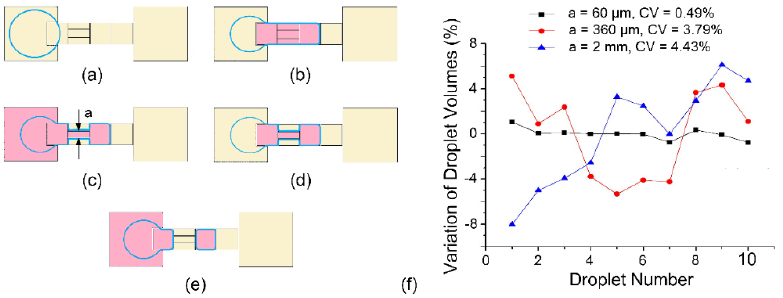
Figure 3. Droplet dispensing process with a new electrode design. ( a – e ) Schematic of the dispensing process. ( f ) Volume variation of droplets dispensed consecutively with the sub-electrodes of different widths. Each dot is averaged over 5 measurements, and error bars are not shown for visual clarity.